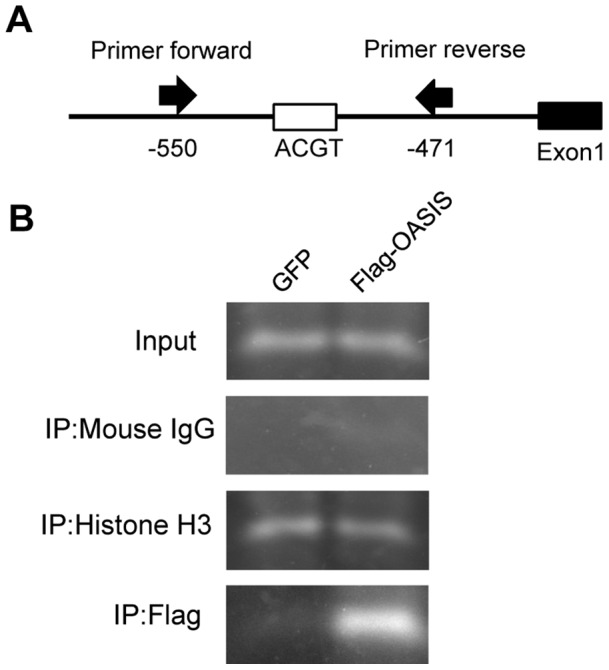
OASIS directly binds to the promoter region in the human VEGFA gene.(A) Schematic representation of the VEGFA promoter and the annealing sites of the primer set used in the ChIP assays. (B) PCR amplification of the VEGFA promoter region including the CRE-like site 4. ARPE-19 cells were transfected with a vector expressing the FLAG-tagged OASIS N-terminus. A GFP expression vector was used as a control. Immunoprecipitation was performed with anti-histone H3, anti-mouse IgG, or anti-FLAG antibodies, followed by the PCR using the specific primer sets.